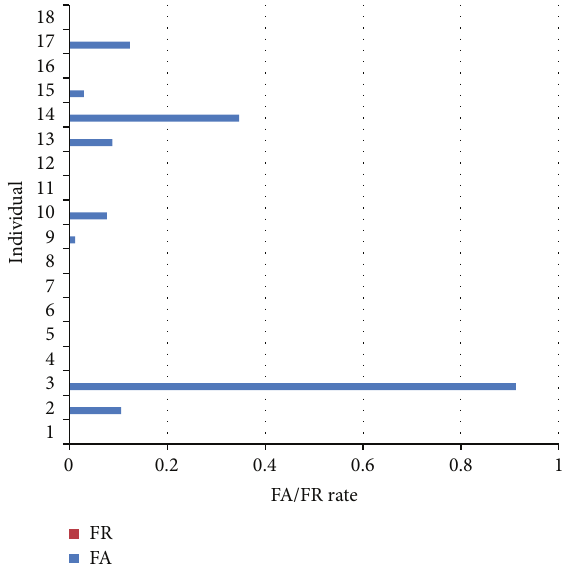
Figure 7: FA and FR of sparse matrix with correlation coefficient computation.